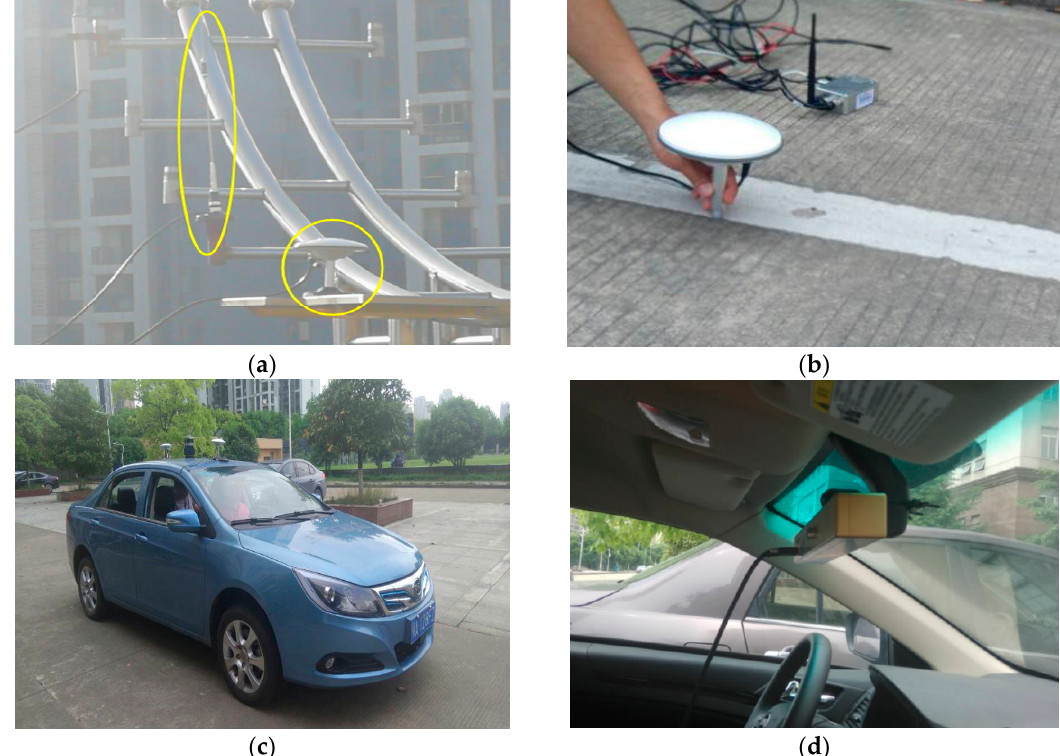
Figure 6. Data acquisition system: ( a ) RTK base station, ( b ) lane coordinate acquisition, ( c ) test vehicle, ( d ) vision system.